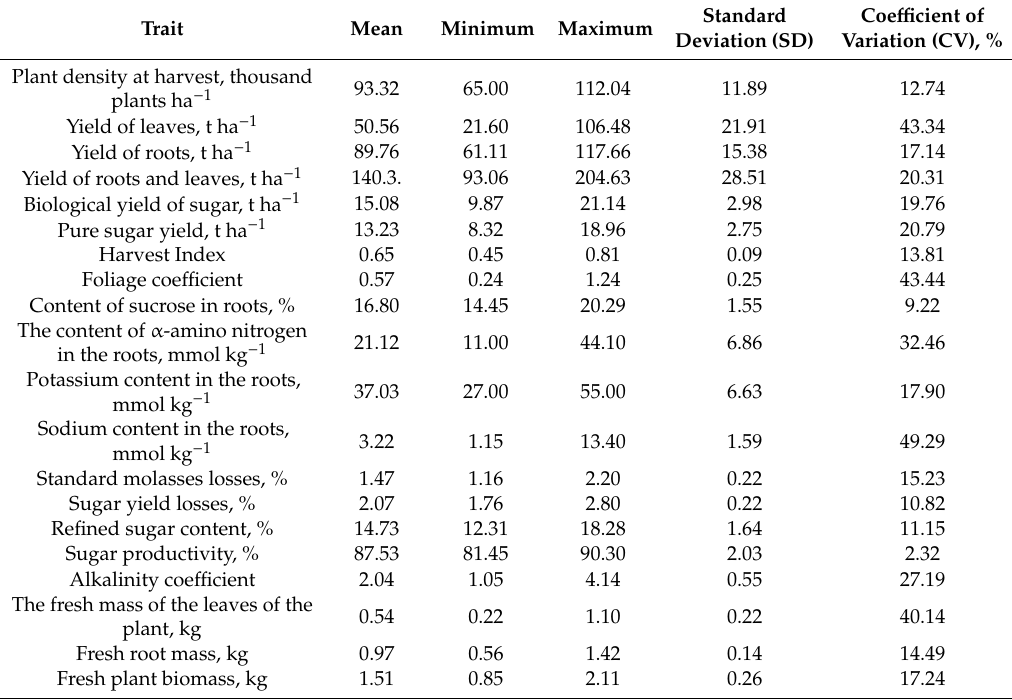
Table 6. Descriptive statistics for all experiments with sugar beet (2017–2019).